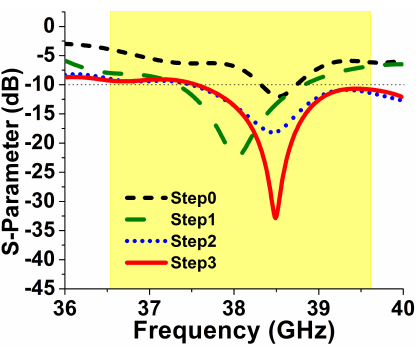
Figure 3. Reflection coefficients for different antenna elements.